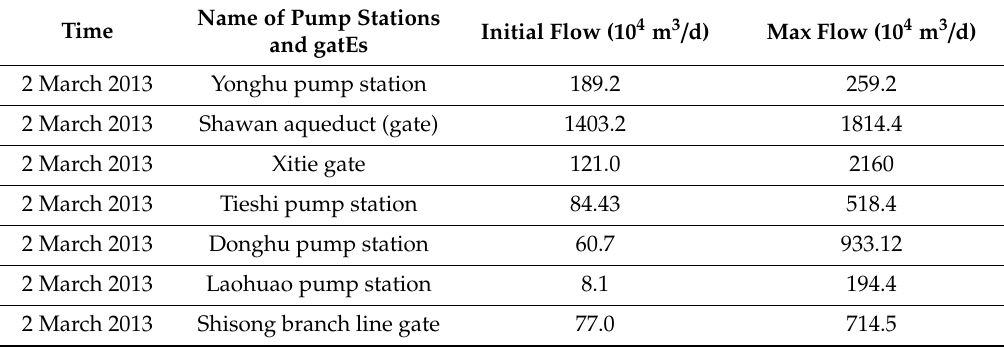
Table 3. The initial state of the pump stations and gates on March 2,